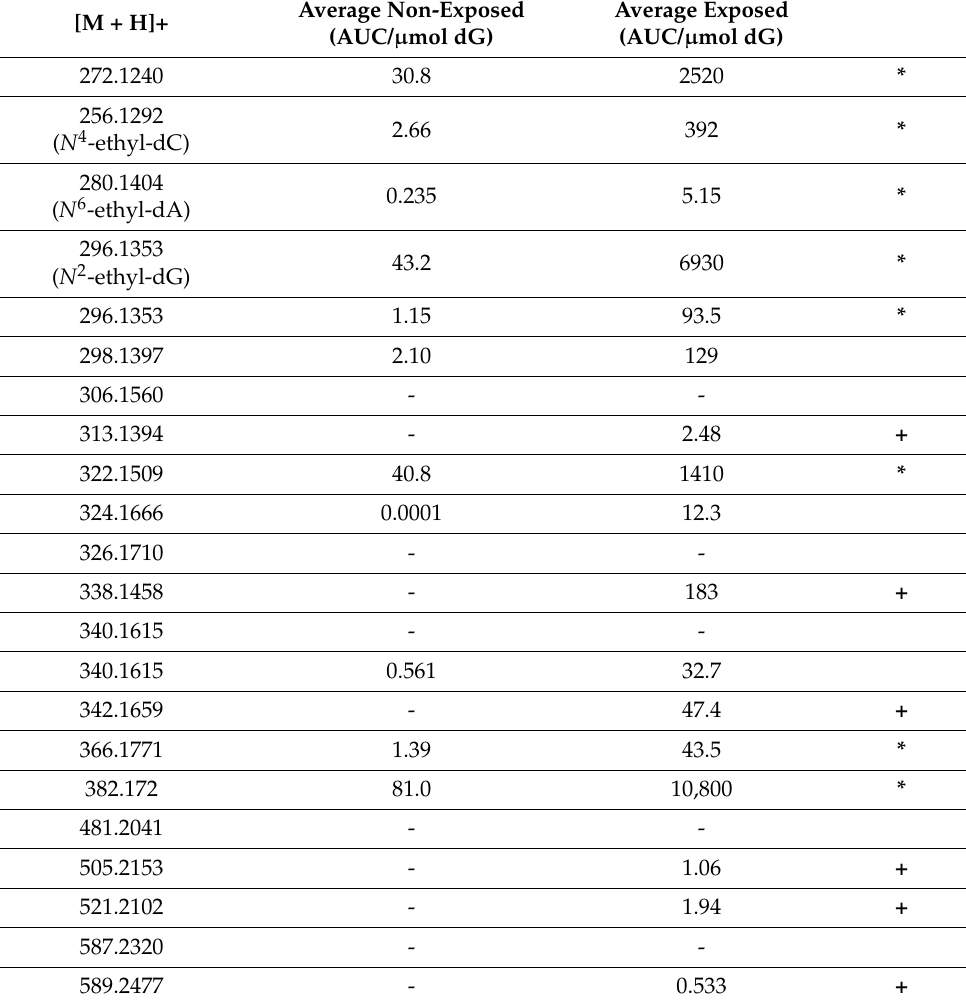
Table 2. For each ion monitored, the average of the AUC was calculated in nonexposed and exposed oral-cell DNA and normalized by the ISs AUC and µ mol of dG. The adducts that were only present after exposure are labelled as “+”, while those present in samples before and after exposure were labelled as “*”, when the levels increased significantly after exposure ( p ≤ 0.05). Average Non-Exposed Average Exposed [M + H]+ (AUC/ µ mol dG) (AUC/ µ mol